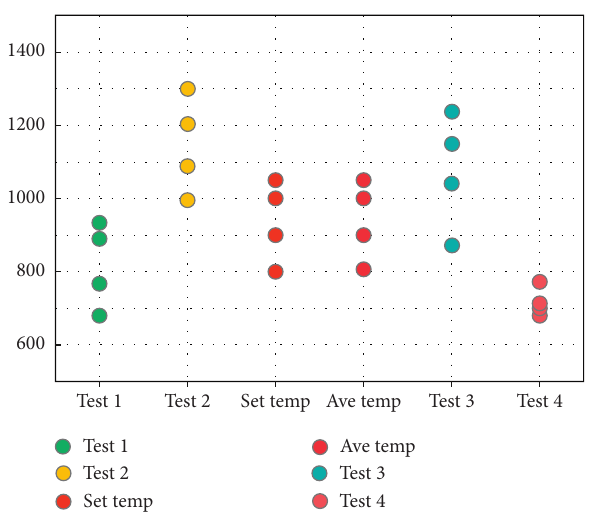
Figure 8: Relationship between experimental data and target